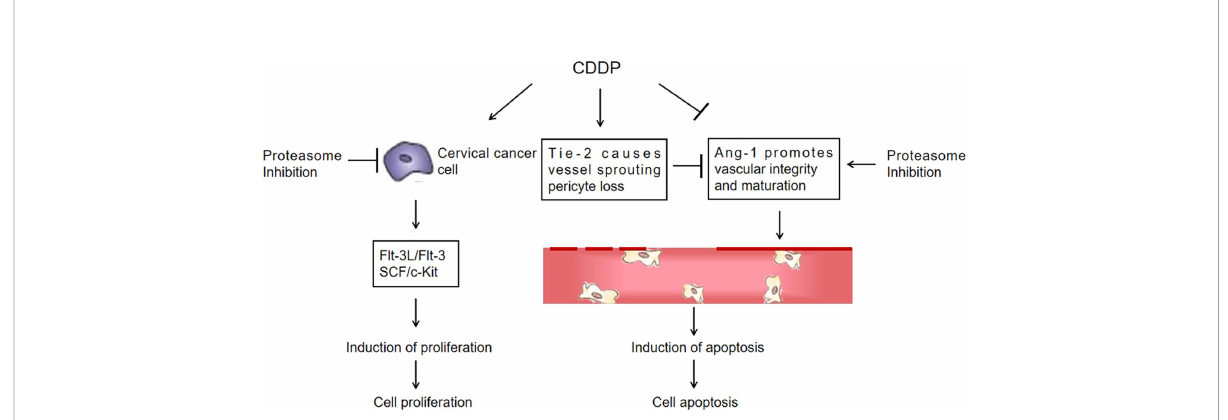
FIGURE 8 A proposed schematic of the cytotoxic effect of marizomib on cervical cancer. The illustration depicts the proposed signaling events from proteasome inhibition, leading to the upregulation of Ang-1 expression and the downregulation of Flt-3L, SCF and Tie-2 expression in cervical cancer xenografts, promoting vascular normalization and ultimately cell